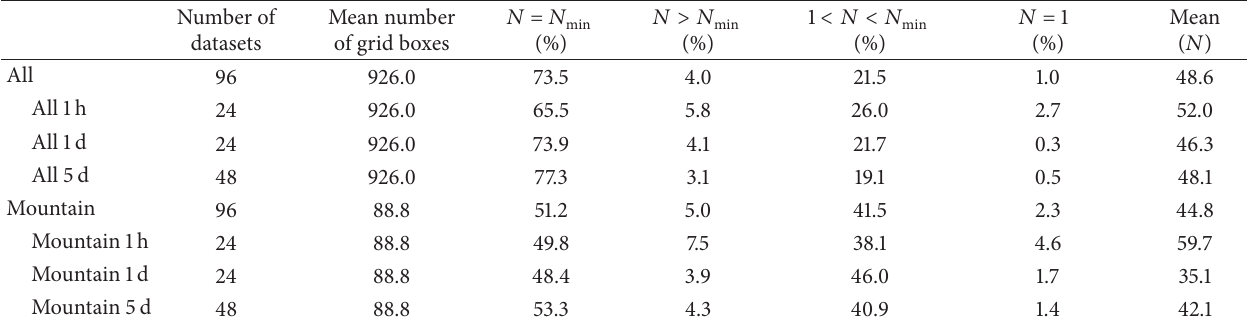
Table 2: Statistics of the size of the pooling groups, averaged across 12 RCMs and two time slices (1961–1990, 2070–2099). For the definition of “mountain” grid boxes, see